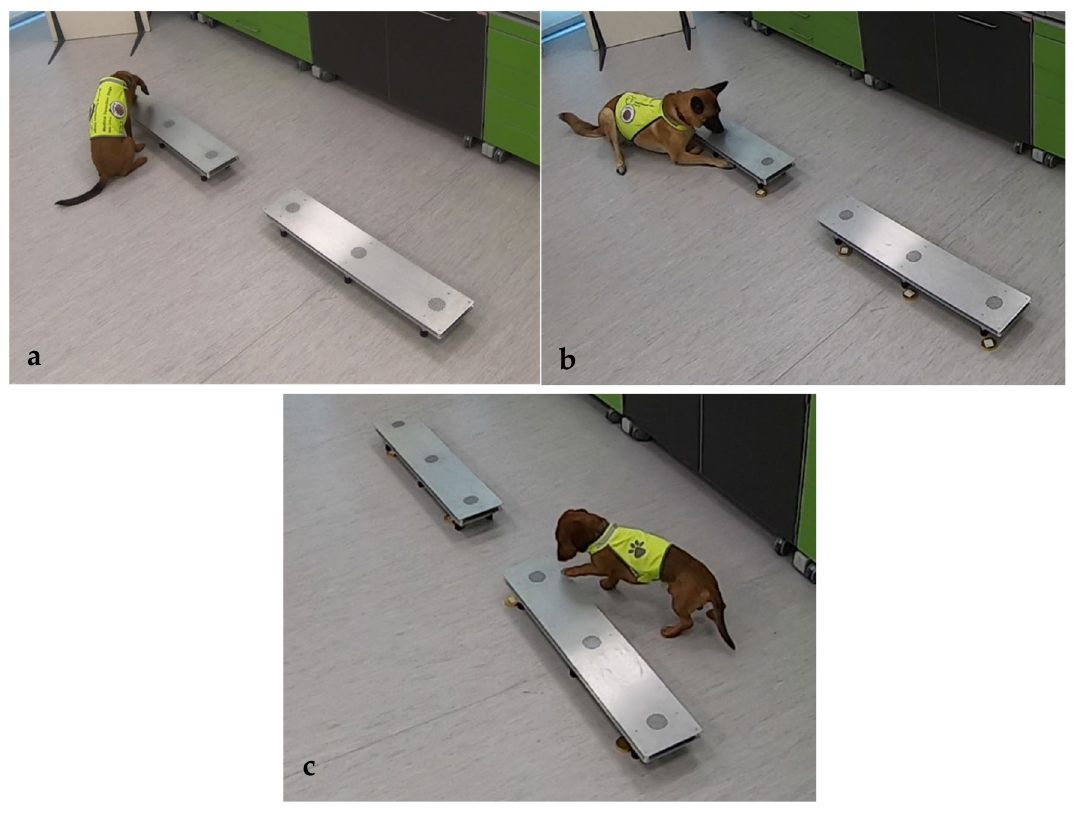
Figure 2. Helix ( a ) Nala ( b ) and Otto ( c ) indicate the correct position respectively by sitting, lying, and scratching directly in front of/on the sample